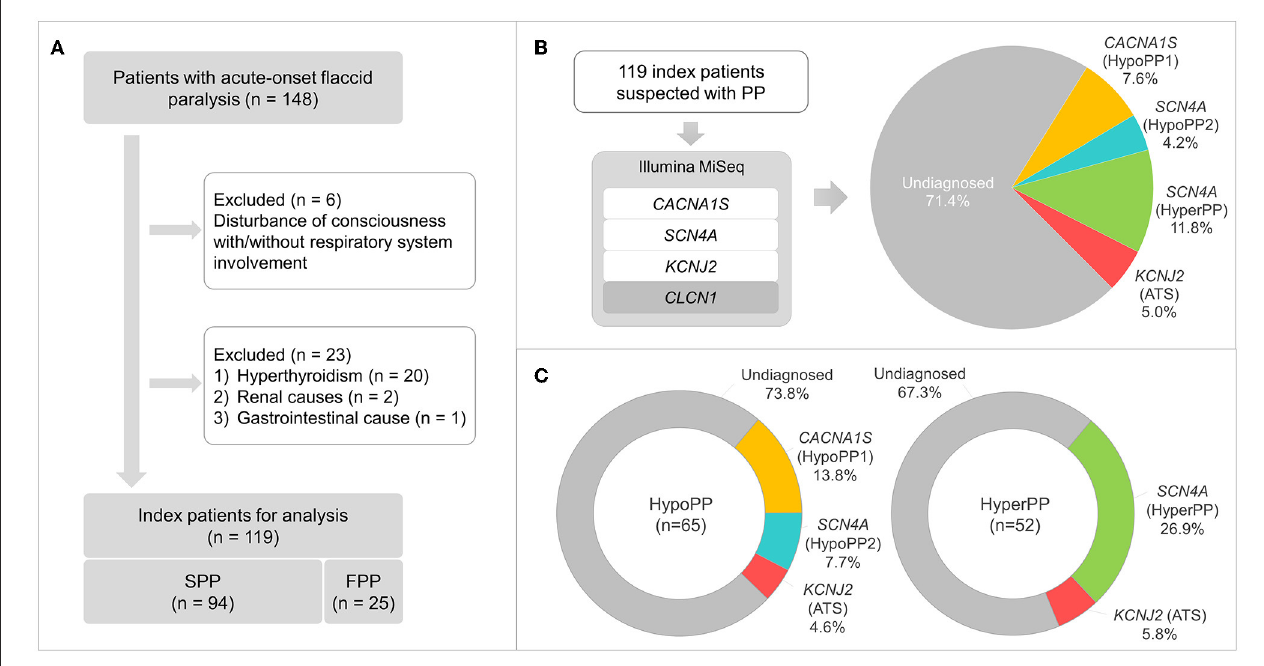
FIGURE1 Patient selection flowchart, gene panel sequencing workflow, and findings. (A) Inclusion and exclusion criteria of patients clinically suspected with periodic paralysis (PP), and 119 index patients, consisting of 94 and 25 cases with sporadic (SPP) and familial PP (FPP), respectively, are selected for the following analysis. (B) Gene panel sequencing with Illumina MiSeq demonstrates a molecular diagnostic rate of 28.6%, and the genetic proportions are presented. (C) Genetic proportions of hypoPP ( n = 65) and hyperPP ( n = 52)